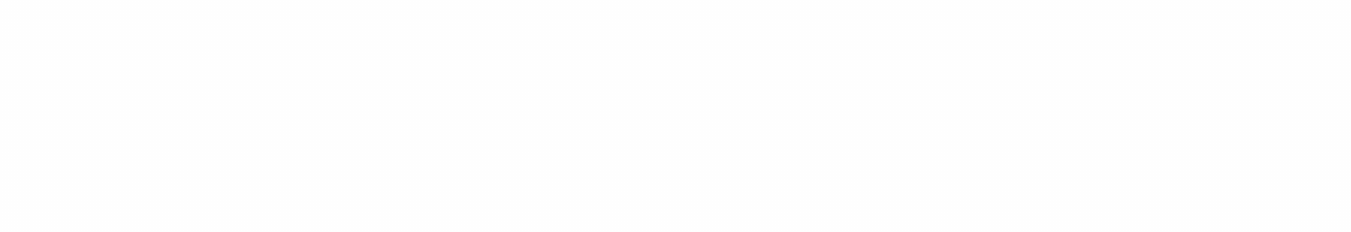
FIGURE 4 The attractor in E-Y plane with noise (c 0.33, a=0.01). FIGURE 6 A trajectory of E with noise (c=0.33,